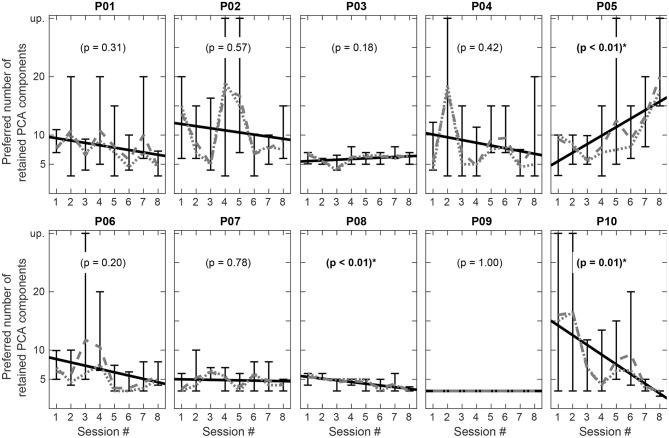
Preferred number of retained components in each session per participant. Vertical bars represent the overall range of ratings in the particular session, dashed and dotted lines show the mean and median for each session. The black solid line shows a linear regression over all sessions. A positive gradient of the regression line indicates a tendency toward lower, a negative gradient toward higher complexity reduction over time. Statistically significant regressions are indicated by (*), unprocessed signals are denoted by “up”.